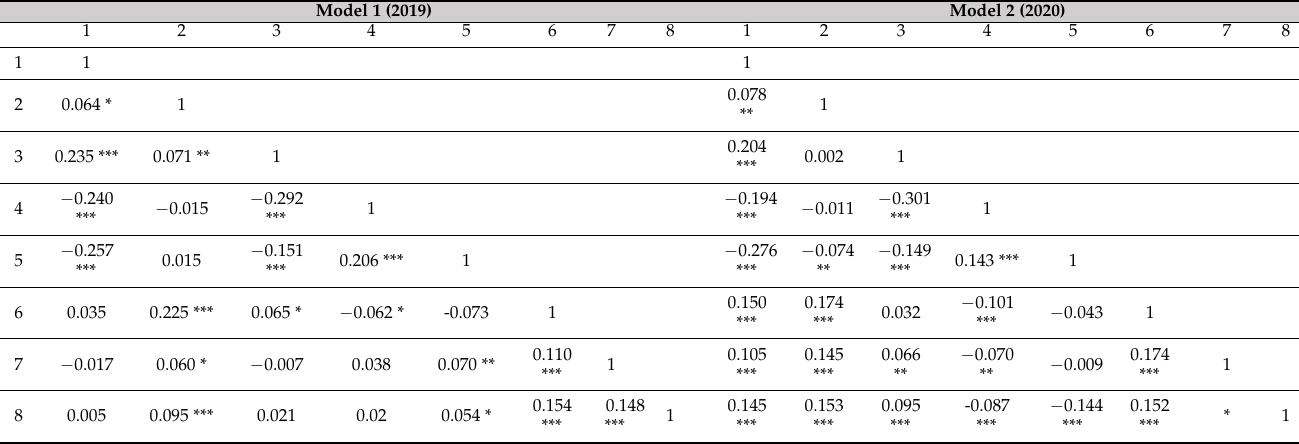
Table 4. Bivariate relationships between